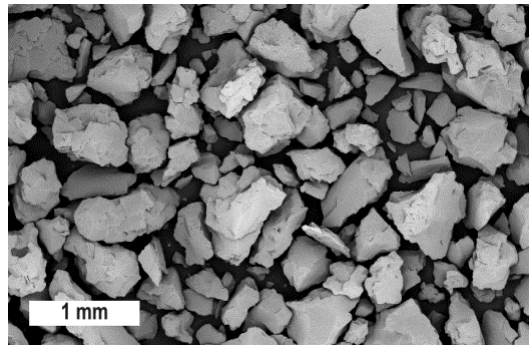
Figure 2. SEM image of the quartz sand used in abrasion and erosion wear